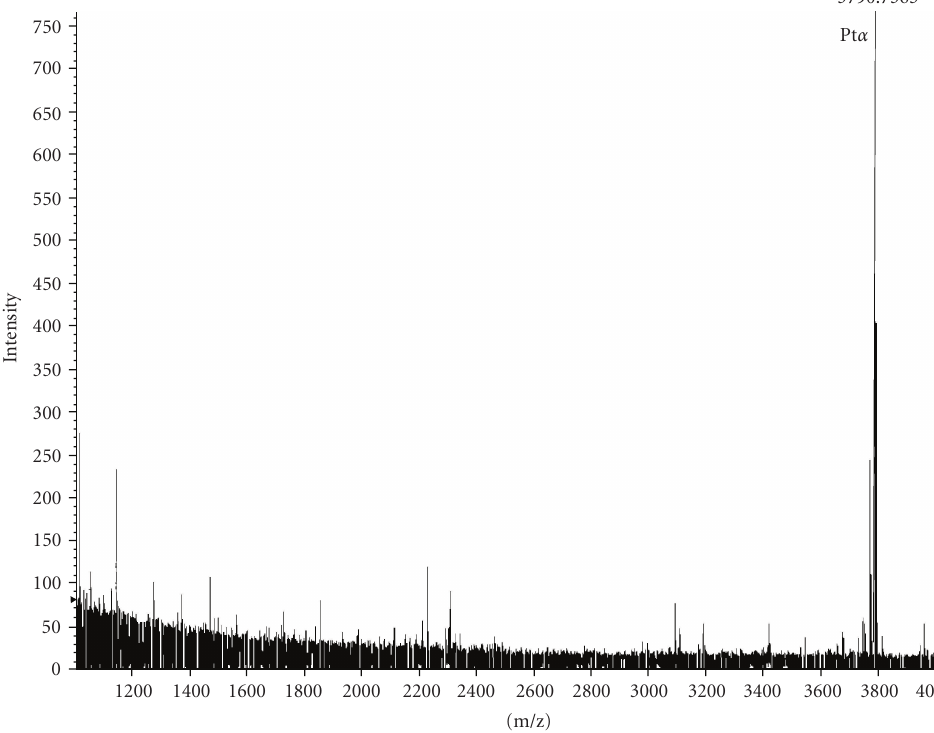
Figure 3: Identification and validation of peak 3790 as prothymosin- α . Mass spectrum of proteins from fraction Q3 that bound to Q10 ProteinChip array and was analyzed on QSTAR XL instrument (mass range from 1000 to 4000